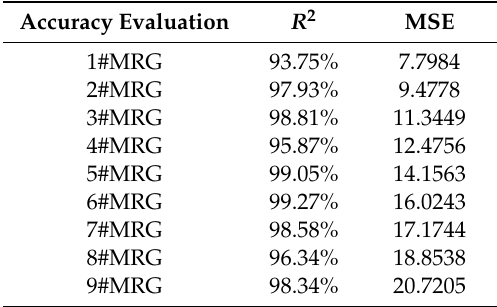
Table 6. Model accuracy in terms of R 2 and